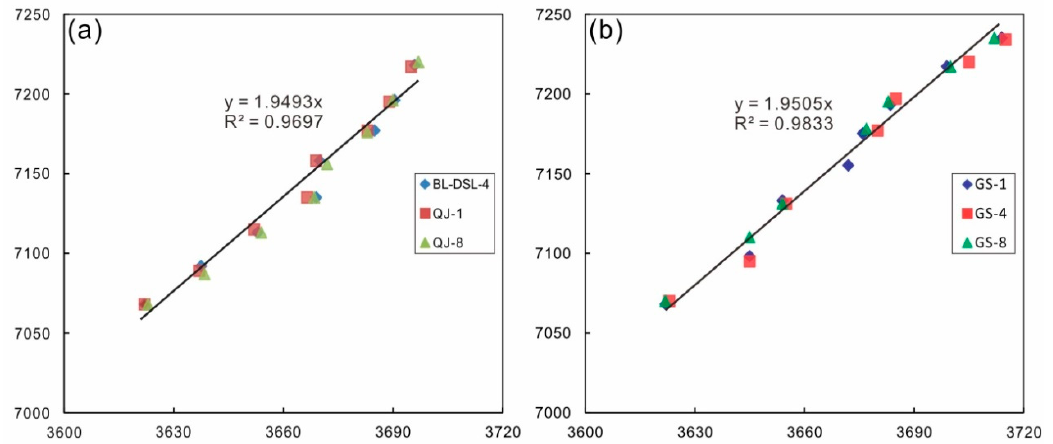
Figure 9. Relationship between the overtone vibrations and stretching vibrations of OH: ( a ) relationship for kaolinite; ( b ) relationship for dickite.